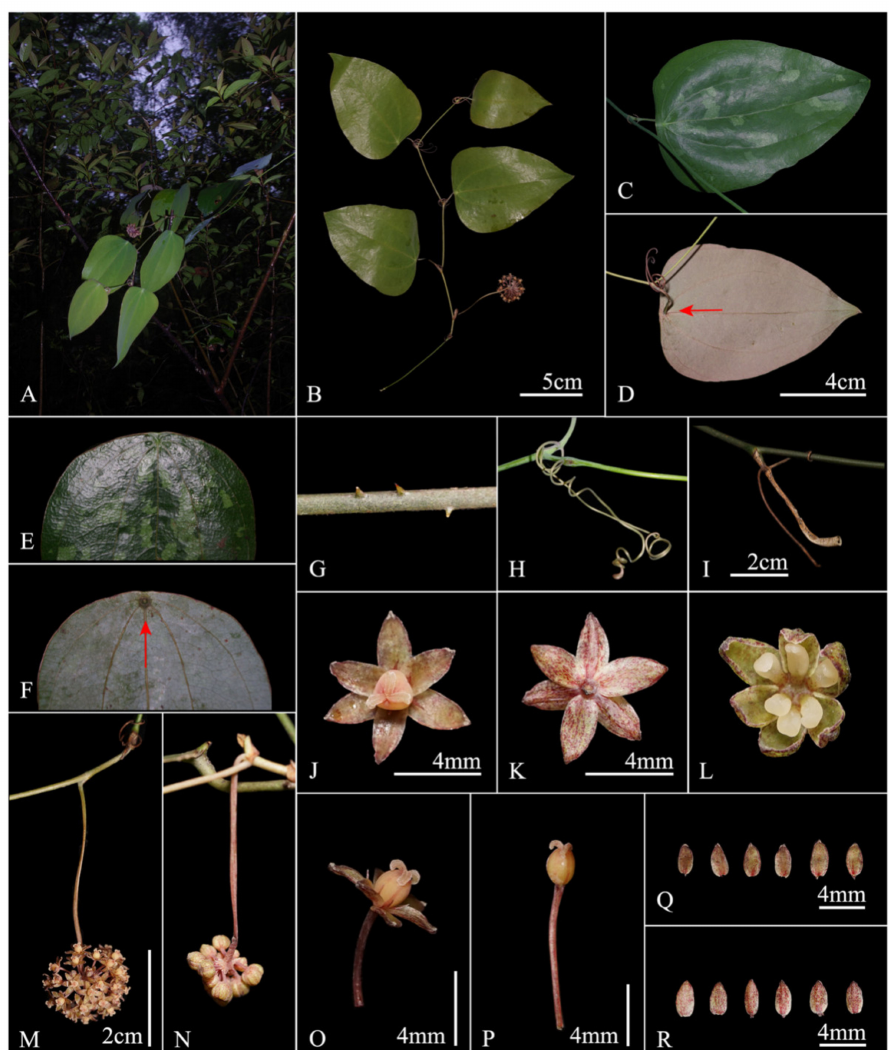
Figure 4. Smilax weniae P. Li, Z.C. Qi & Yan Liu, sp. nov. ( A ) Plant habit; ( B ) Flowering branch; ( C ) Stem with a leaf in adaxial view; ( D ) Stem with a leaf in abaxial view; ( E ) Leaf base in adaxial view; ( F ) Leaf base in abaxial view, showing peltate leaf; ( G ) Stem, occasionally prickly; ( H ) Tendrils; ( I ) Petiole; ( J ) Pistillate flower in front view; ( K ) Pistillate flower in rear view; ( L ) Staminate flower in front view; ( M ) Pistillate inflorescence; ( N ) Staminate inflorescence, flowers unopened; ( O ) Pistillate flower in side view; ( P ) Pistillate pedicel and pistil in side view; ( Q ) Tepals in front view; ( R ) Tepals in rear view. The red arrow points to the petiole insertion point of the peltate